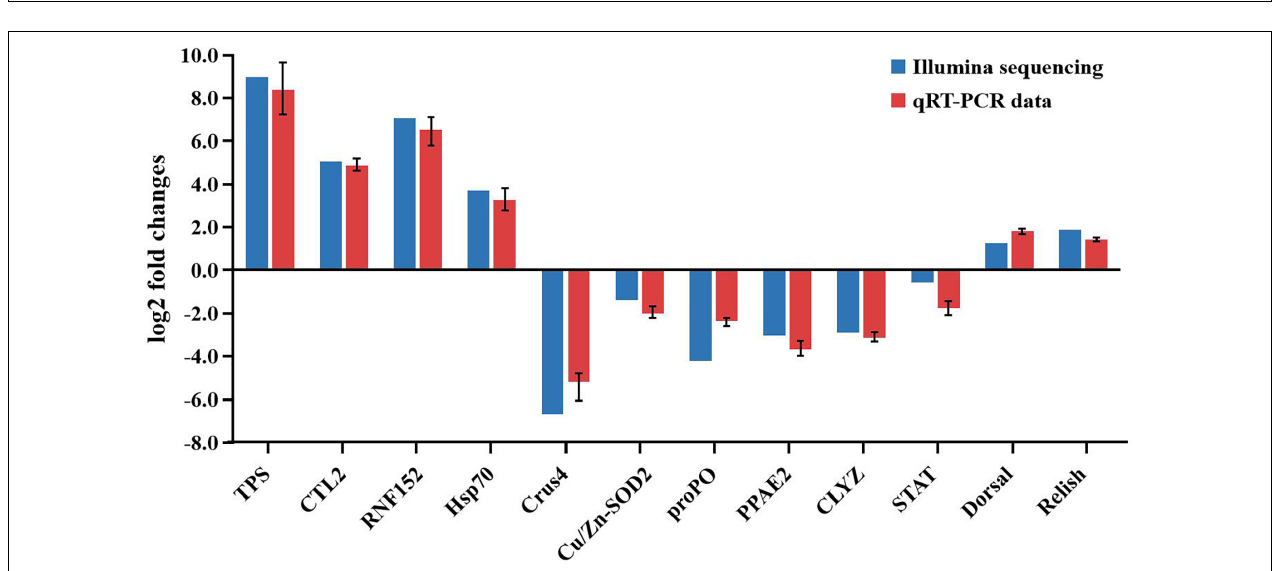
FIGURE 9 | Distribution of SSR nucleotide classes among different nucleotide types found in the transcriptome of Marsupenaeus japonicus . The X -axis indicates the type of SSRs. The Y -axis indicates the number of SSRs.